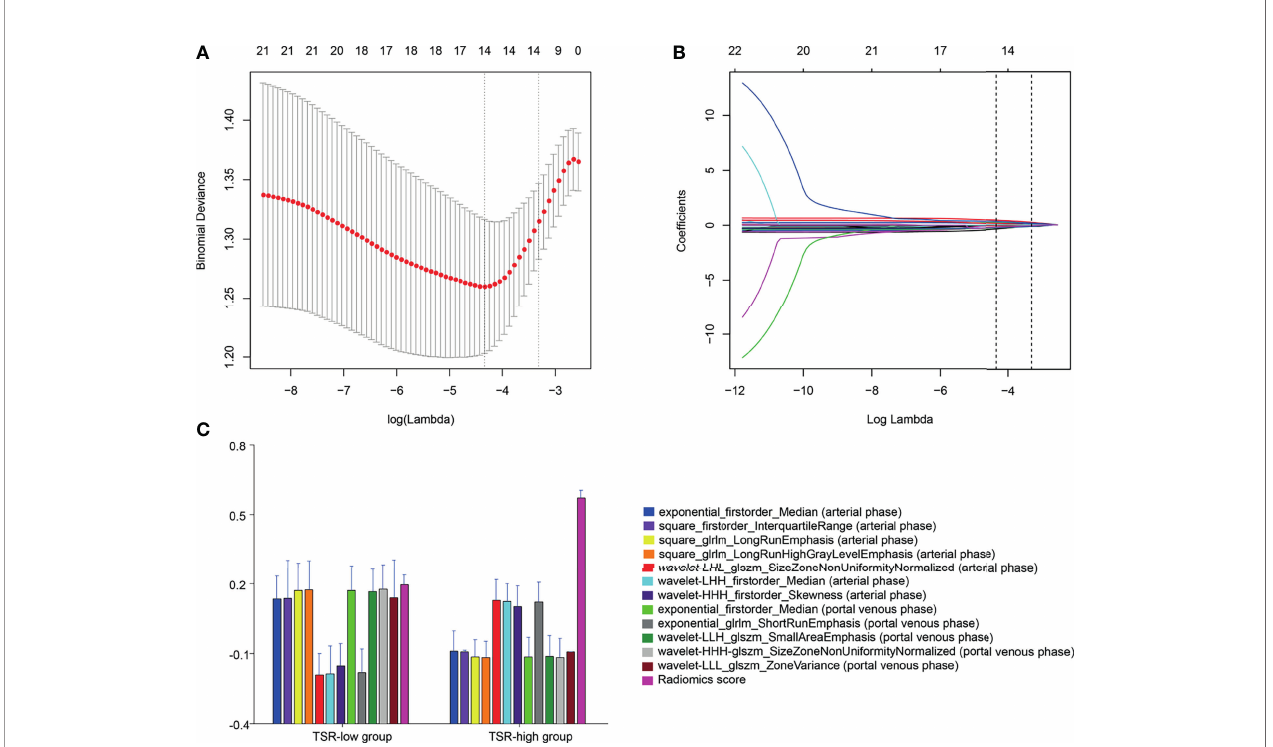
FIGURE 4 | Radiomic feature selection by a parametric method, the least absolute shrinkage and selection operator (LASSO). (A) Selection of the tuning parameter ( l ) in the LASSO model via 10-fold cross-validation based on minimum criteria. Binomial deviances from the LASSO regression cross-validation procedure are plotted as a function of log( l ). The y-axis indicates binomial deviances, whereas the lower x-axis indicates the log( l ). Numbers along the upper x-axis represent the average number of predictors. Red dots indicate the average deviance values for each model with a given l . The vertical bars through the red dots depict the upper and lower values of the deviances. The vertical black lines de fi ne the optimal values of l , where the model provides its best fi t to the data. An optimal l value of 0.036 with a log( l ) of -3.315 is selected. (B) LASSO coef fi cient pro fi les of the 25 texture features. The dotted vertical line is plotted at the value selected using 10- fold cross-validation in (A) The 12 resulting features with nonzero coef fi cients are indicated on the plot. (C) The error-bar chart of the 12 radiomics features and radiomics